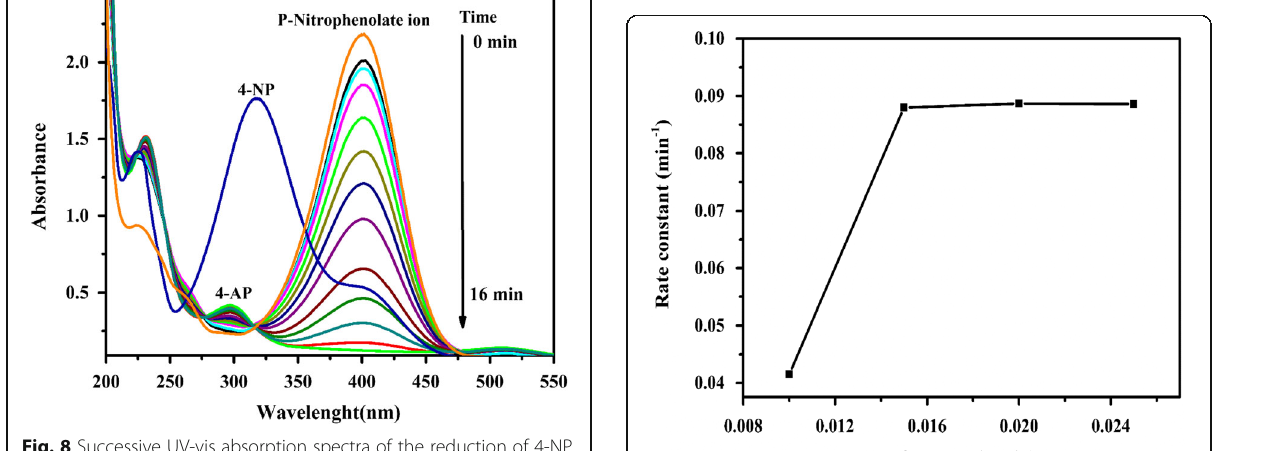
Fig. 8 Successive UV-vis absorption spectra of the reduction of 4-NP by NaBH